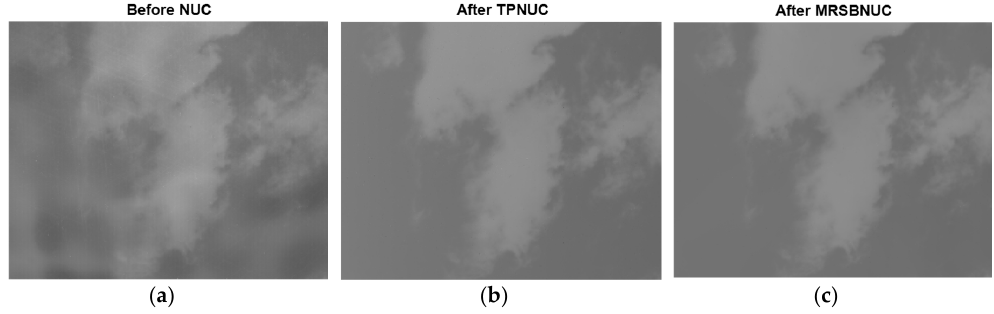
Figure 13. Sky scene with clouds: ( a ) before NUC, ( b ) after TPNUC and ( c ) after MRSBNUC.